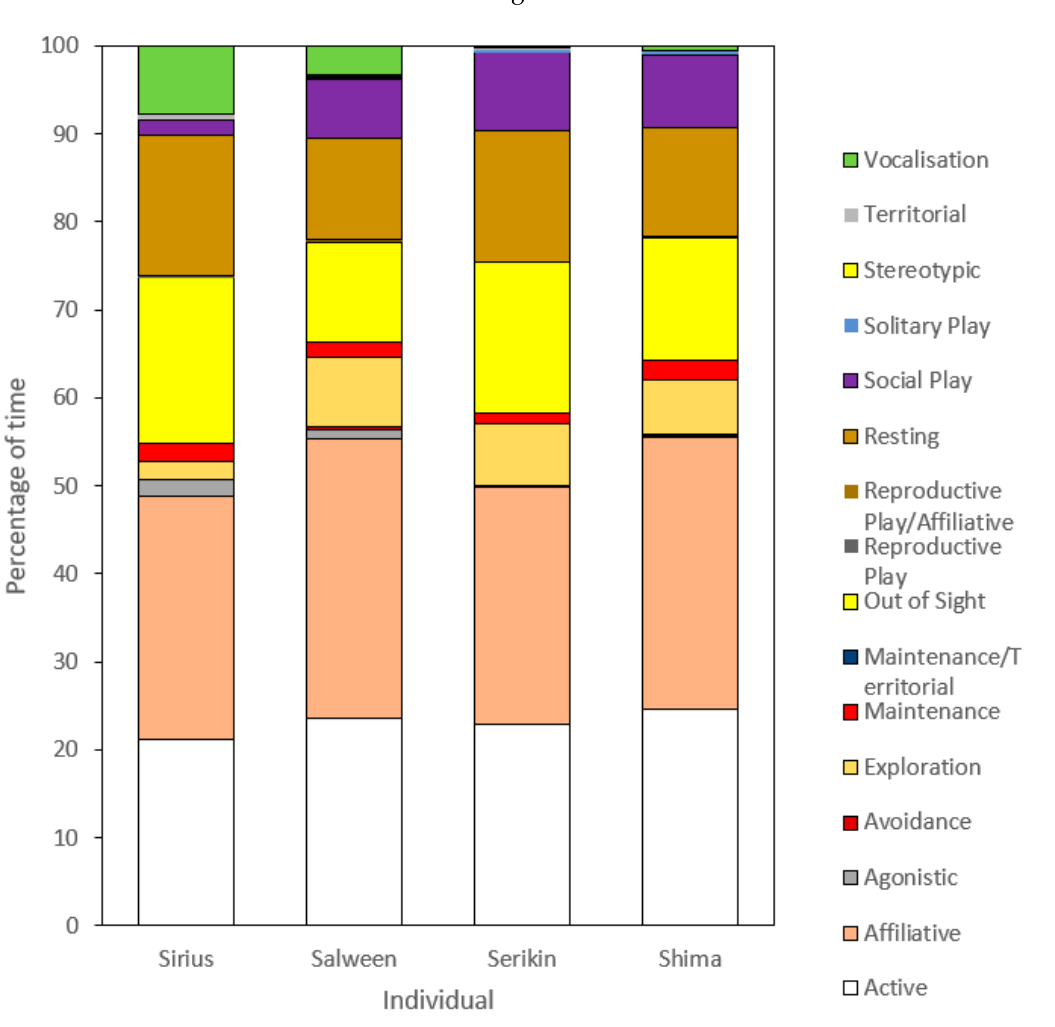
Figure 3. Activity budget of overall duration (%) of behavioral observations for the male (Sirius), female (Salween), and two cub tigers (Serikin and Shima) at Parc des Félins.